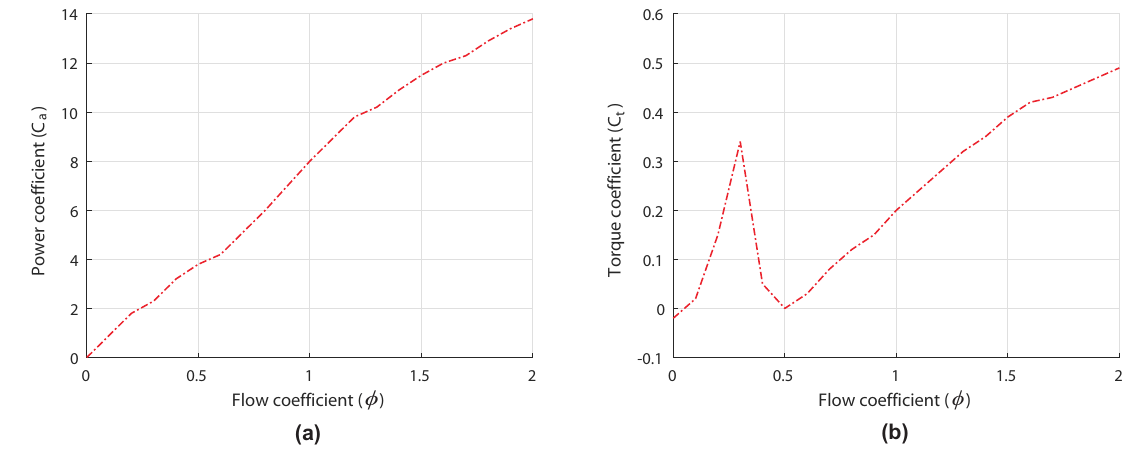
Figure 3. Characteristic curves of the installed Wells turbine [27]. ( a ) Power coefficient versus flow coefficient. ( b ) Torque coefficient versus flow